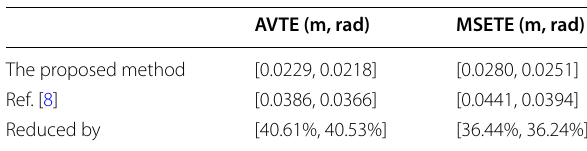
Table 8 Experimental data in 0.5 m/s ocean